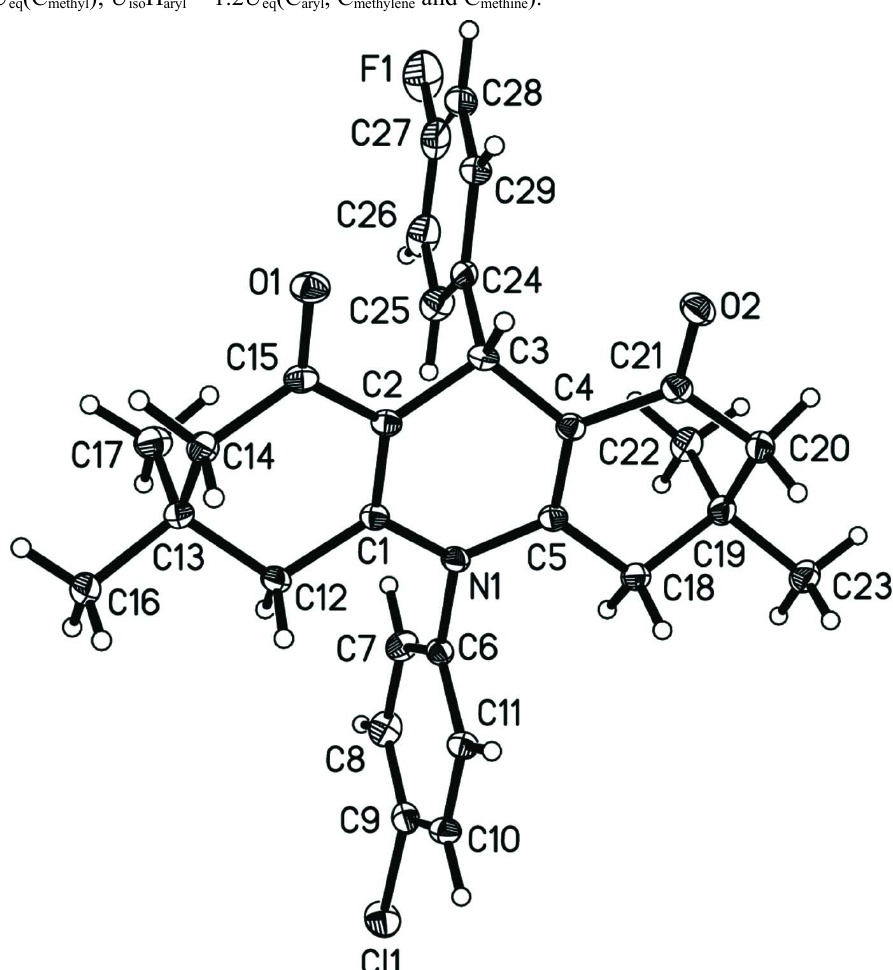
Figure 1 The title molecule with the displacement ellipsoids shown at the 50% probability